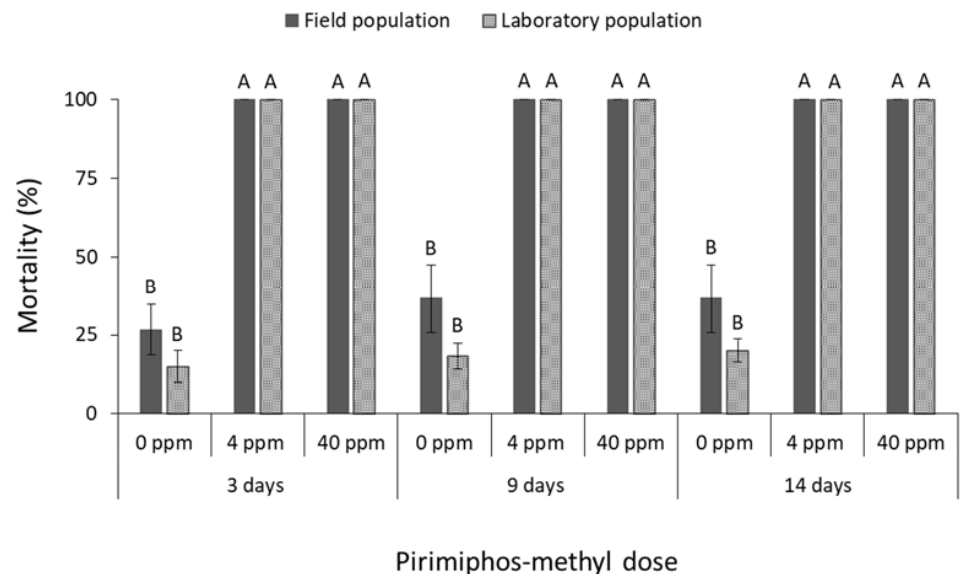
Figure 6. Mean (% ± SE) adult mortality of field and laboratory populations of S. zeamais after 3, 9 and 14 days of exposure to different concentrations of pirimiphos-methyl (within each exposure interval and population, means followed by the same letter are not significantly different; where no letters are present, no significant differences were noted; HSD test a 0.05).